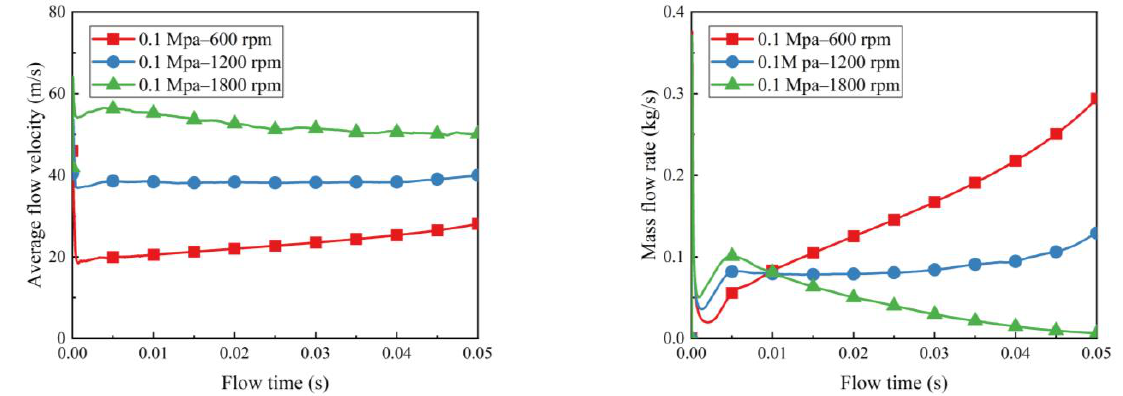
Figure 13. Variation of outlet average flow velocity at variable speed ( left ) and mass average flow velocity ( right ).